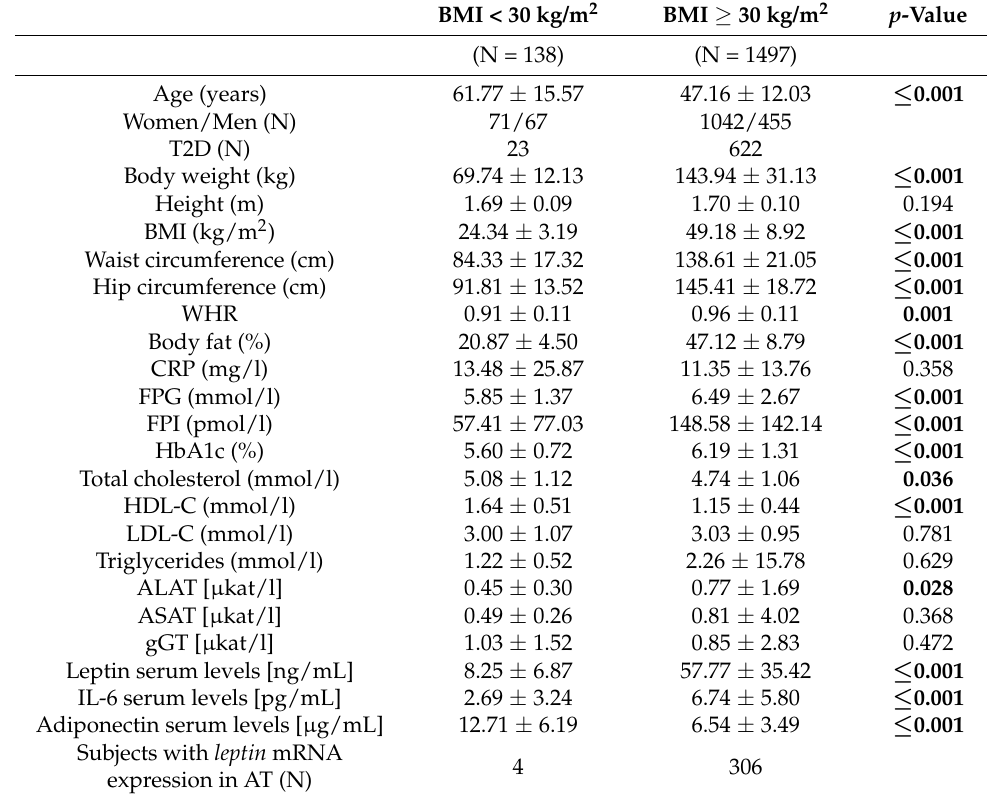
Table 1. Anthropometric and metabolic characteristics of the cohort